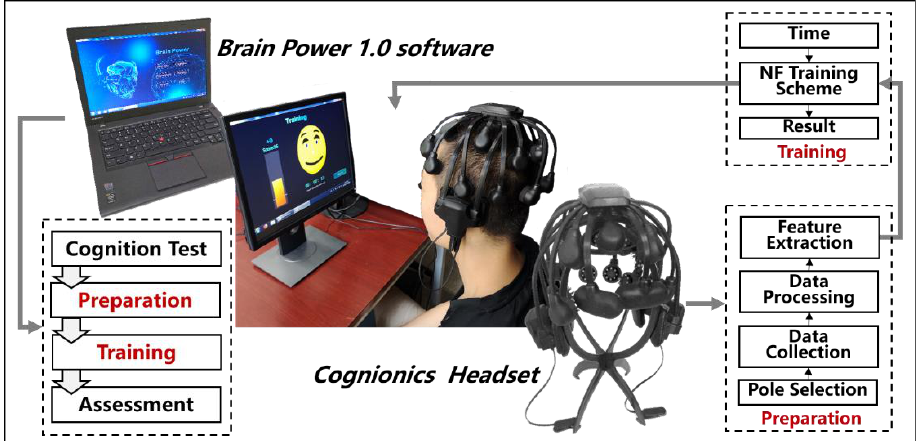
Figure 1. Neurofeedback system.